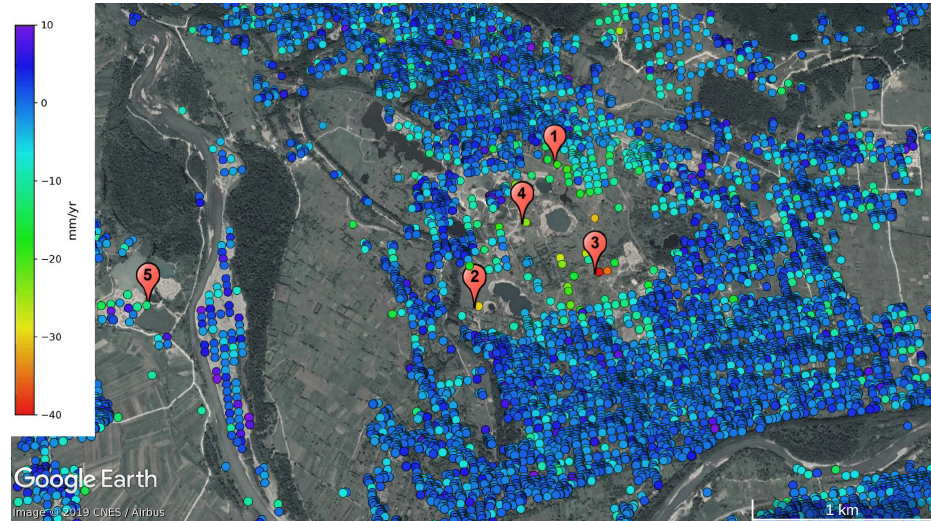
Figure 5. Linear rate of line-of-sight deformation from Sentinel-1 ascending pass for the investigated area (see explanation of numbers in the text). Contains modified Copernicus Sentinel data (2014–2019), background © Google.